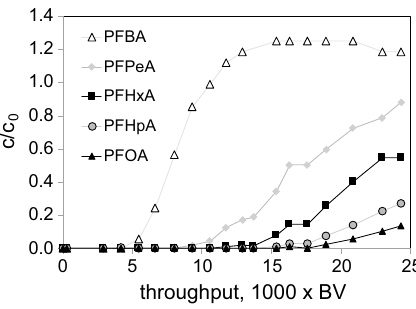
Fig. 5 Normalised breakthrough curves of PFAS in the contaminated groundwater for GAC‑CC (bed depth: 1 m, filtration velocity 7.5 m/h)